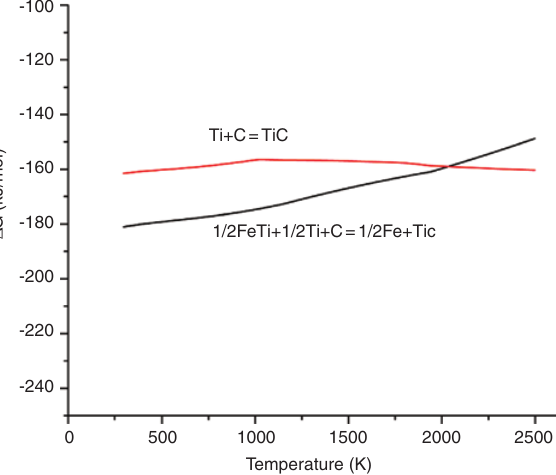
Figure 4: Ellingham-Richardson diagram for the formation reaction of TiC and Fe/TiC.